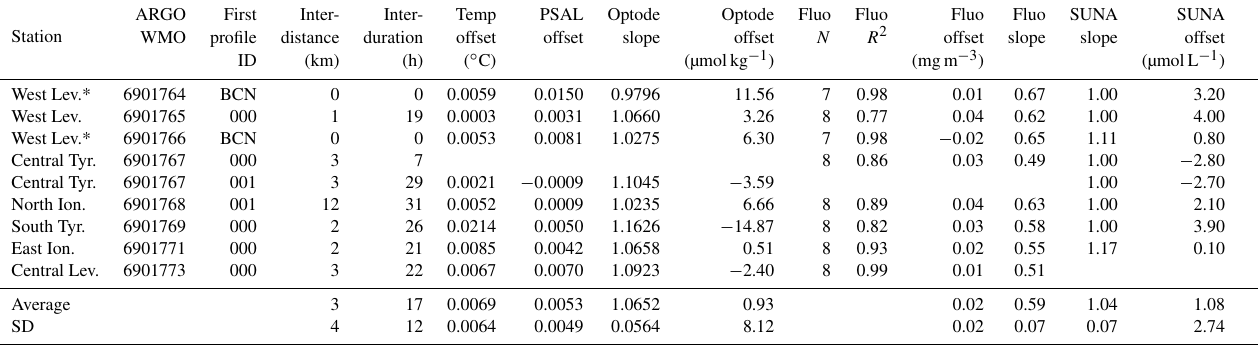
Table 2. BGC-Argo float summary. For every BGC-Argo float deployed with a CTD cast of reference, the distance and duration with the first profile of the float are indicated. The results of metrological verification by parameter are reported. SD stands for standard deviation. PSAL: practical